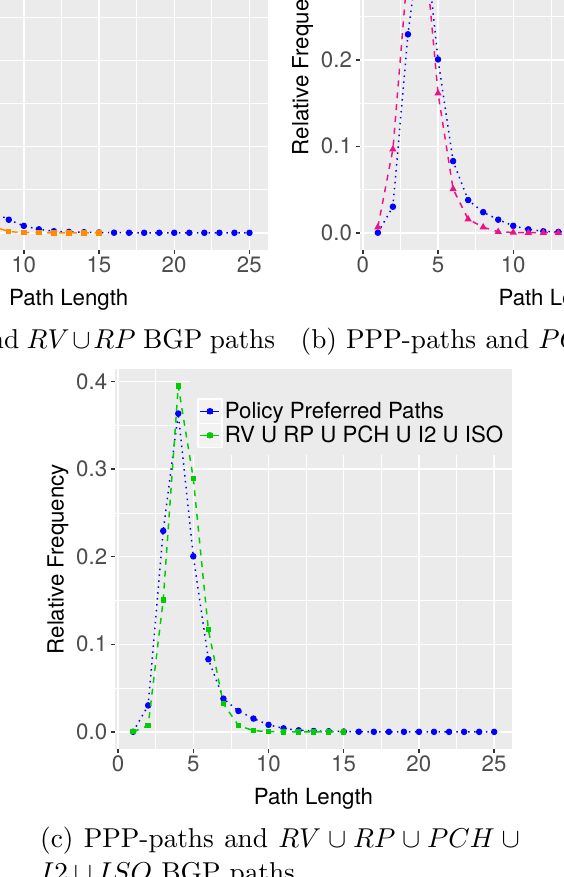
Figure 9: Relative path lengths comparison of PPP-paths and raw BGP